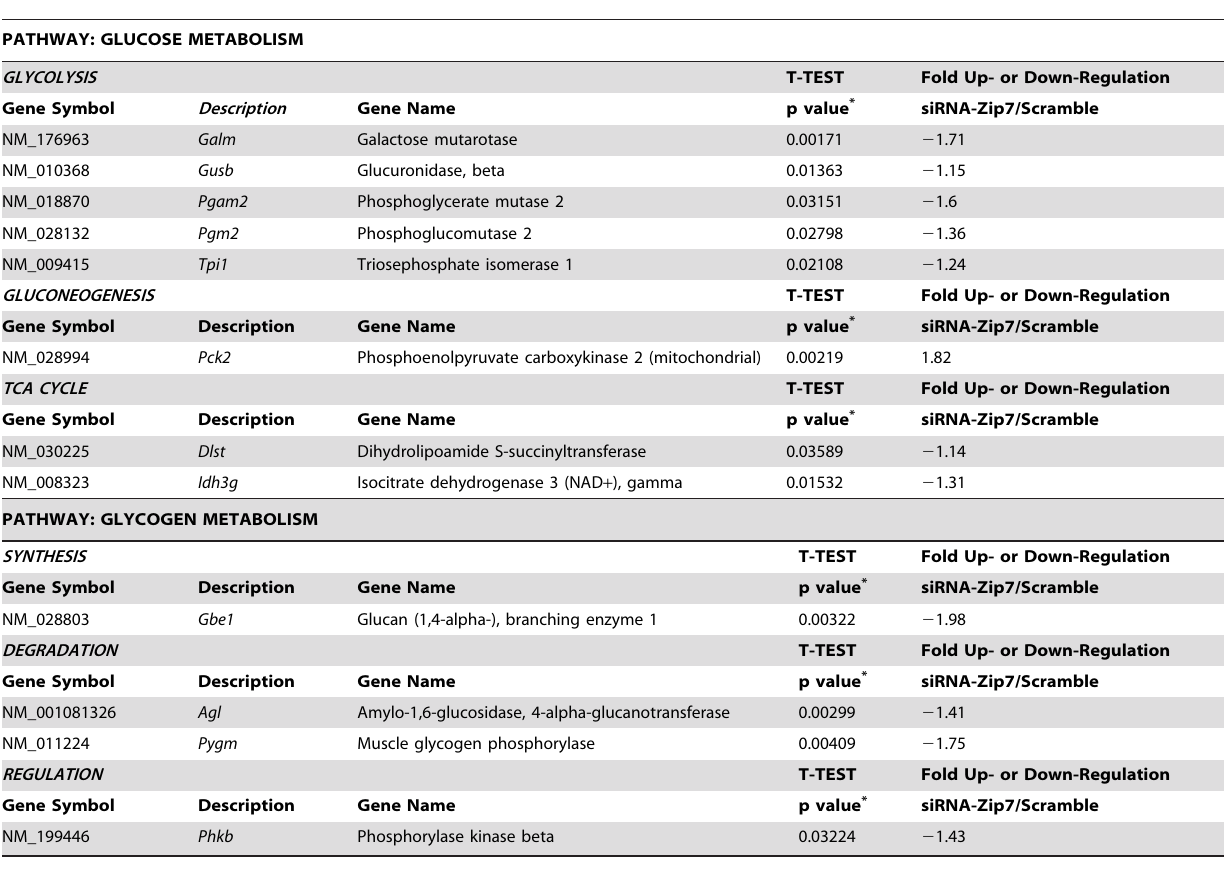
Table 1. Fold changes in expression of glucose metabolic genes in the siRNA-Zip7 compared to the scramble control.